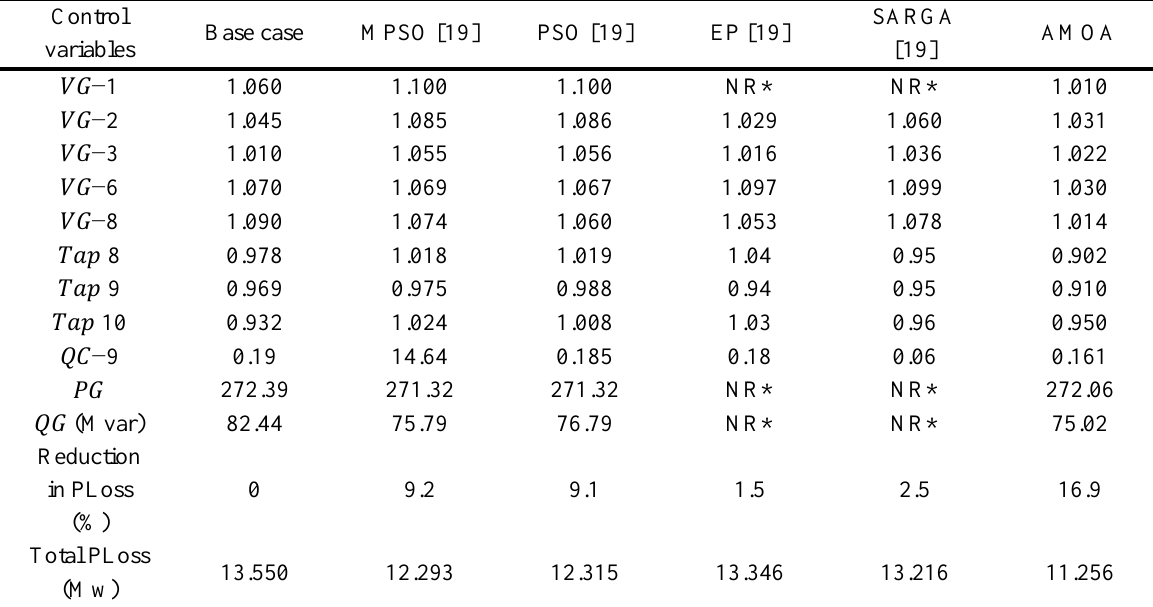
Table 3. Simulation results of IEEE −14 system.